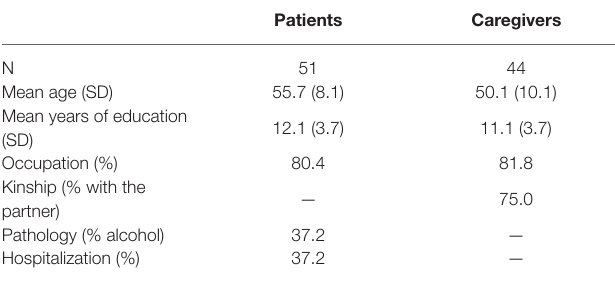
TABLE 1 | Participants’